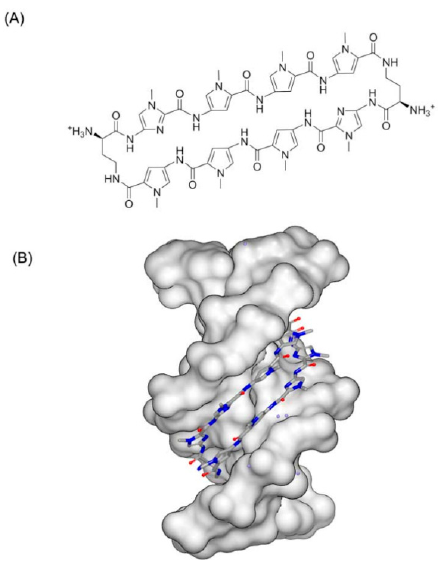
Figure 8. ( A ) Chemical structure of 8 ringmolecule; and ( B ) complex of a DNA with 8 ring molecule (PDB code: 3I5L). The blue and red atoms in the molecule represent nitrogen and oxygen atoms, respectively.